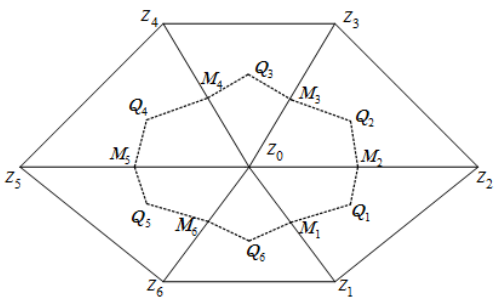
Figure 1. Primal and dual